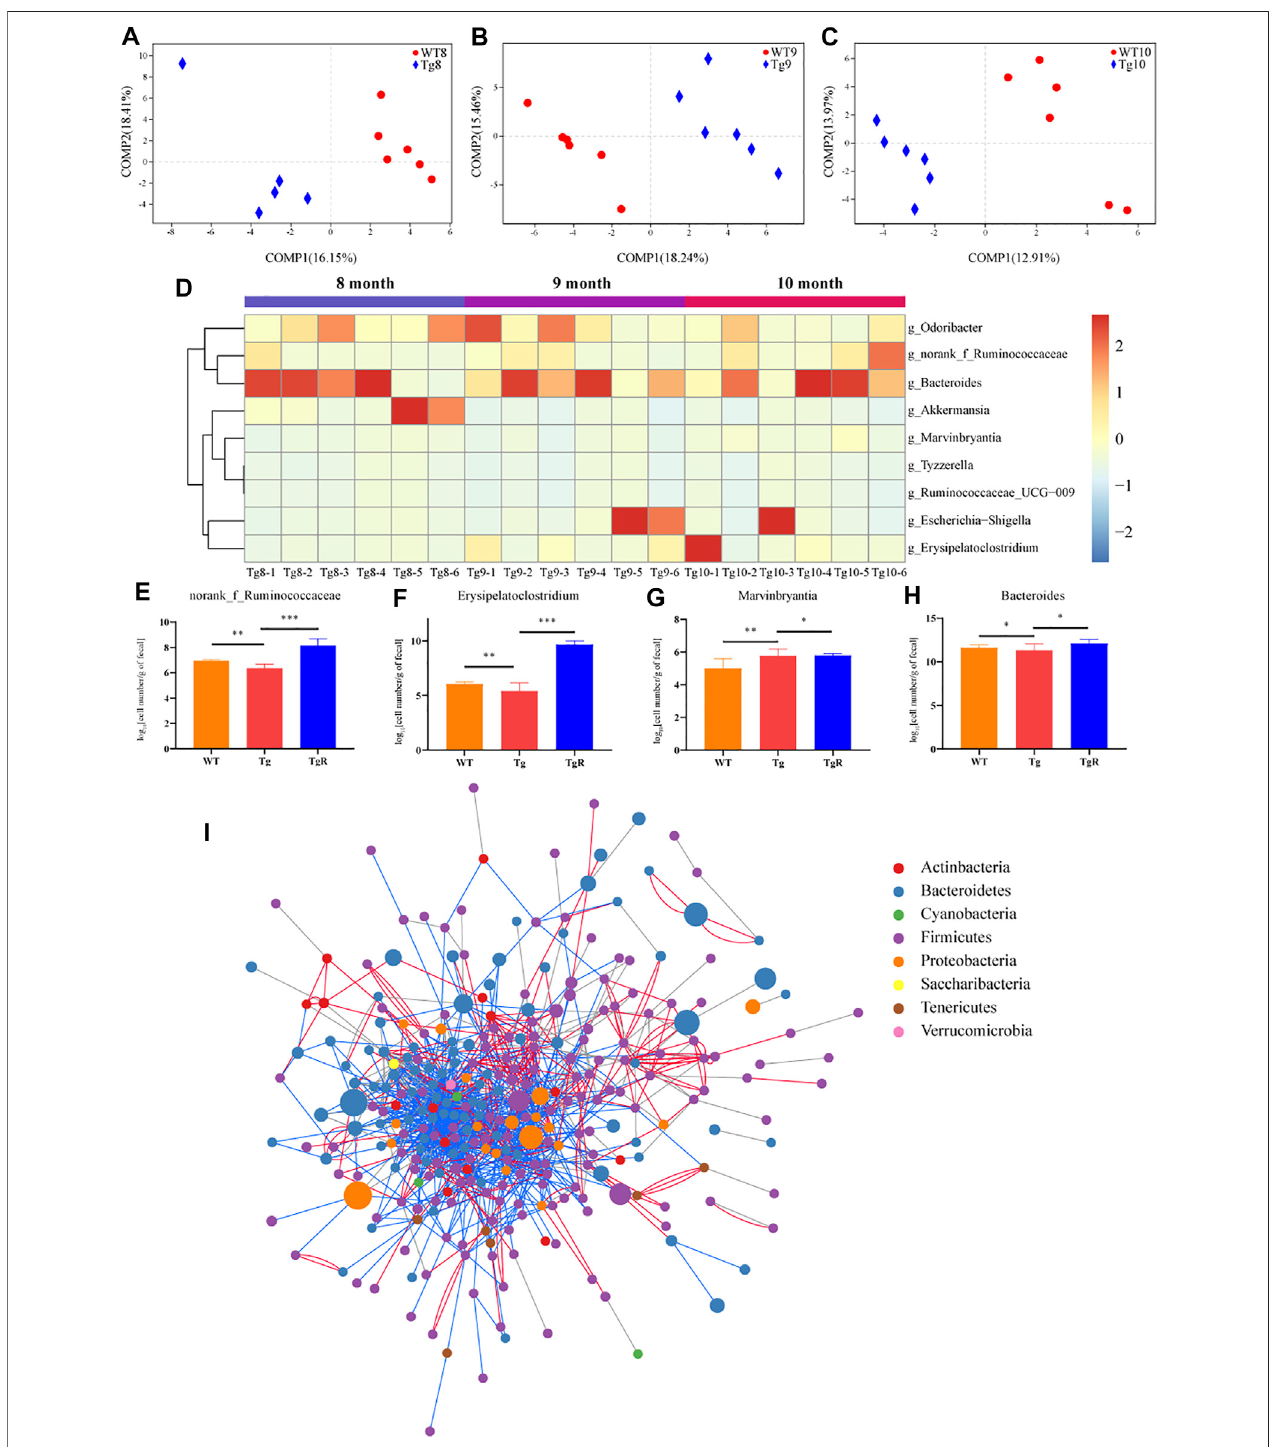
FIGURE 5 | The gut microbiota of Tg mice exhibited a common trend with age. (A – C) PLS-DA score plots of WT and Tg groups. Number in the group name represents months of age. (D) Heatmap formed by the abundance of genera. (E – H) Abundance of the key bacteria in the network, quanti fi ed by species-speci fi c quantitativePCR.* p < 0.05versusTg;** p < 0.01versusTg;** p < 0.001versusTg,*** p < 0.0001versusTg,byWilcoxonrank-sumtest. (I) Co-networkconstructedbyall OTUsinthefecalsamplesofTgmiceatthreetimepoints.ThesizeofthenodeindicatestherelativeOTUabundance;thecolorofthenodeindicatesdifferentphyla; the lines between the nodes indicate co-abundance (red) or co-exclusion (blue) between the nodes.